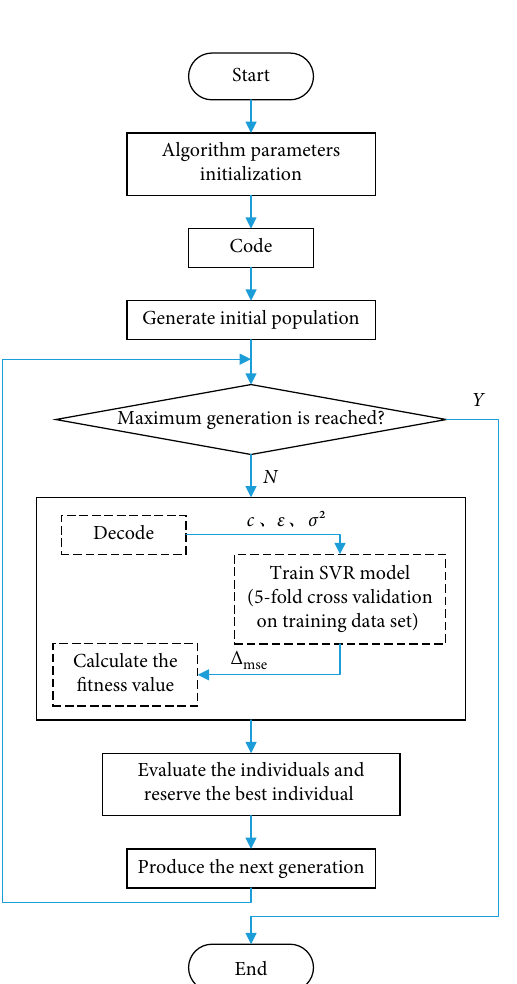
Figure 1: Graphical details of 𝜀 -insensitive loss function [29].